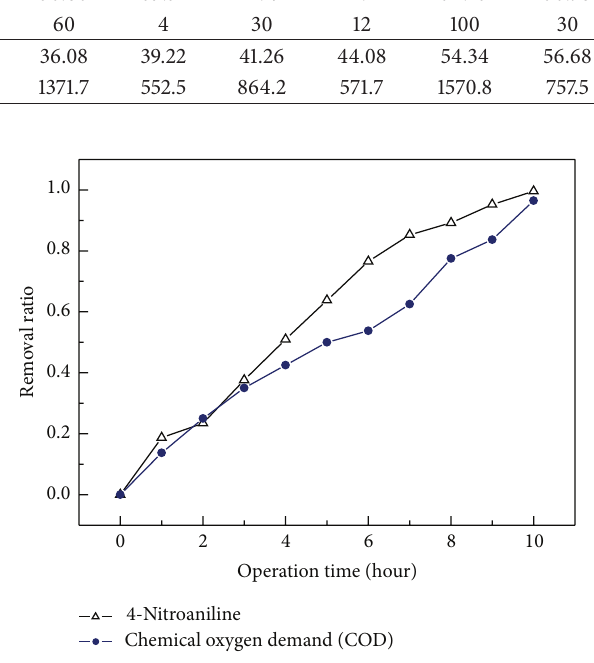
Figure 3: The relationship between removal ratio of 4-nitroaniline and COD removal ratio during the reaction (c (4-nitroaniline) =